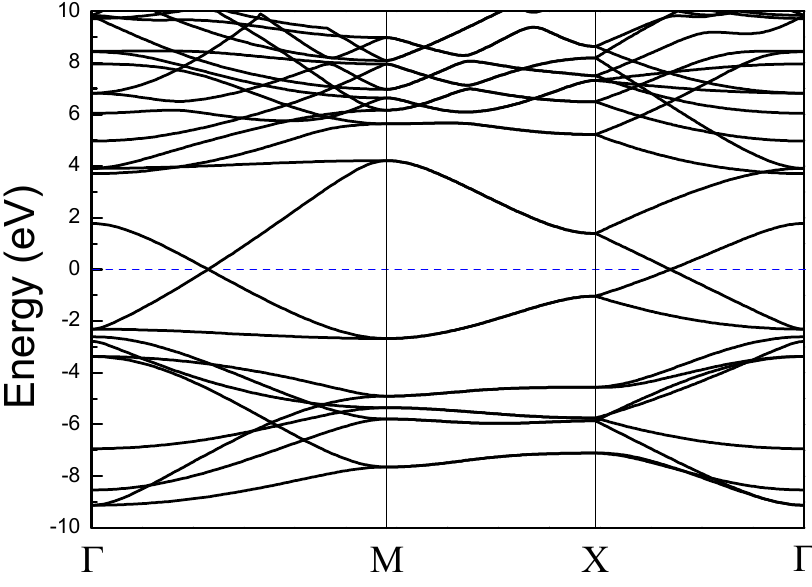
Figure 2. Band structure of the octagon-structure carbon monolayer.